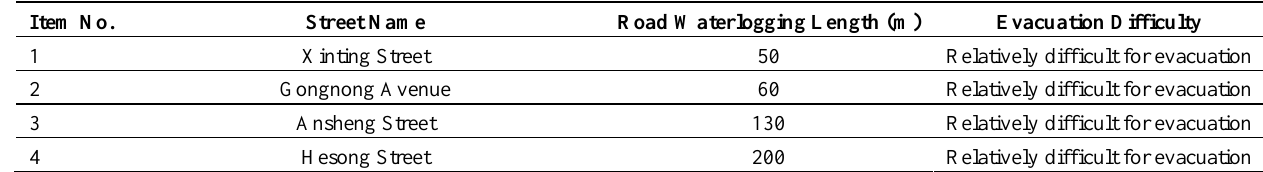
Table 5. Difficulty evaluation results of residents’ evacuation under the scenario of a 100-year frequency